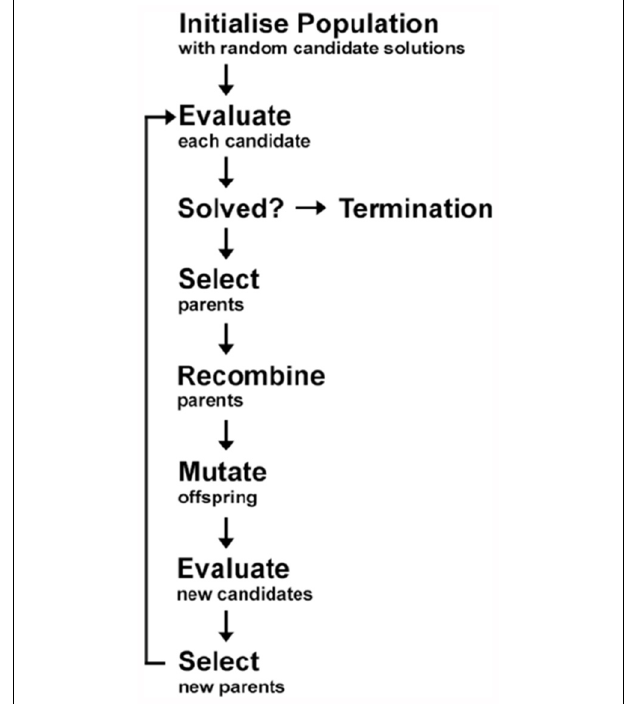
FIGURE 1 | General diagram of the classification process in Evolutionary Algorithms (EAs). In order to find the optimal model (or candidate), a set of working models are randomly generated (Step 1: initialize population). The models (or candidates) are then evaluated to assess their accuracy rate (Step 2: evaluate). In order to achieve the maximum accuracy rate, certain models (or candidates) are selected for use in the subsequent generation of models (Step 3: select) via recombination (also known as sexual reproduction or crossover) and/or mutation. Recombination is an operator that is applied to two or more selected models (the so-called parents or genotype or chromosomes), by mixing their genetic material (genes), to create one or more new models (the children or new chromosomes or offspring). Mutation is applied to one model (asexual reproduction) or two models (sexual reproduction) and results in one new model. This procedure is repeated for many iterations and the resulting model is evaluated each time (Step 4: evaluate) or until the desired accuracy rate is achieved at which stage a final optimal model is selected and the process is terminated (Step 5: termination). Adapted from Figure 4.5 of Dehsarvi